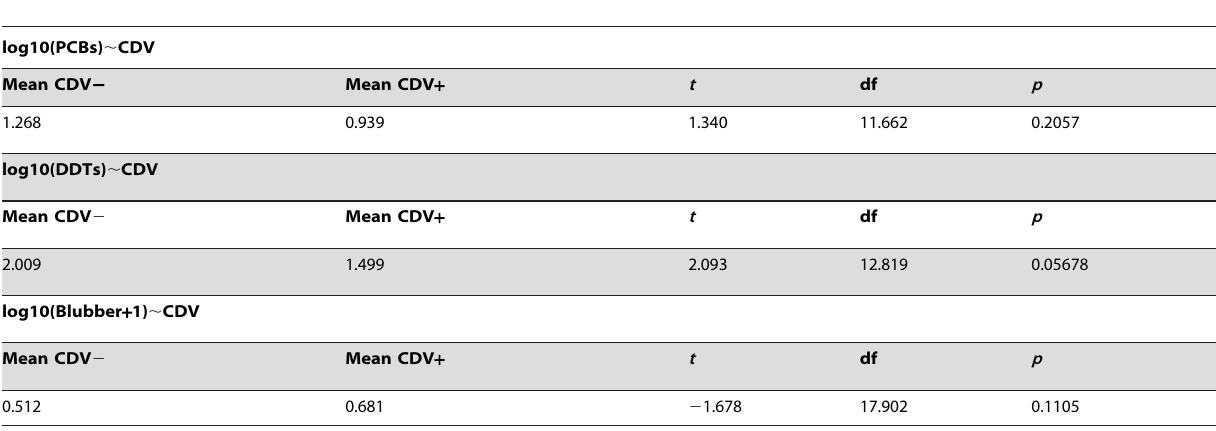
Table 4. Comparison of PCBs, DDTs and Blubber thickness in CDV + and CDV 2 animals (Welch 2 sample t -test).